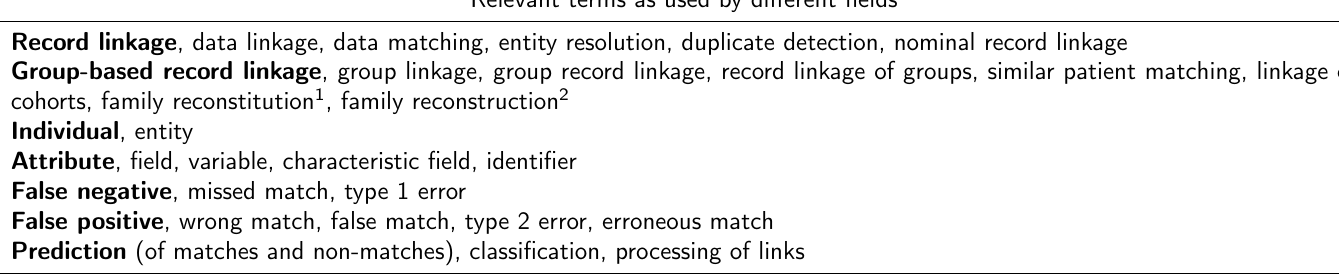
Table 1: Glossary of commonly used terms across disciplines. Each row shows terms describing the same concept as used by different fields. We highlight the terms we use in this paper in